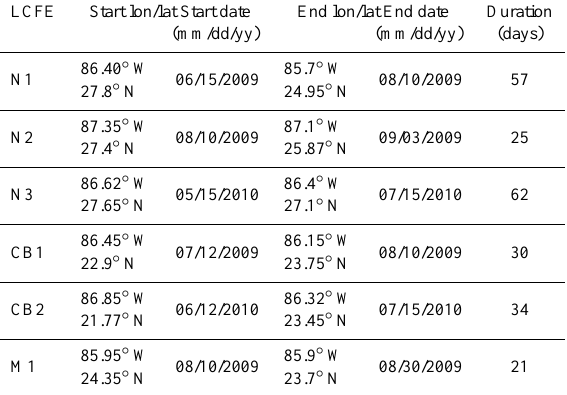
Table 2. LCFE attributes during the Eddy Ekman and Eddy Franklin events. LCFEs are characterized as “N” when in the “N Group” (northern GoM eddies), “CB” when in the “CB Group” (Campeche Bank eddies), and “M” when in the “M Group” (Merged